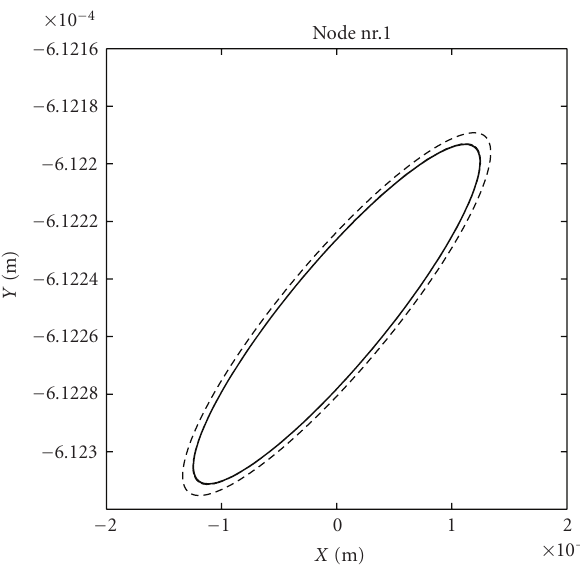
Figure 5: Eigenfrequency and transfer function as function of clearance at zero spin speed. Figure 6: Displacement orbits in Case2.